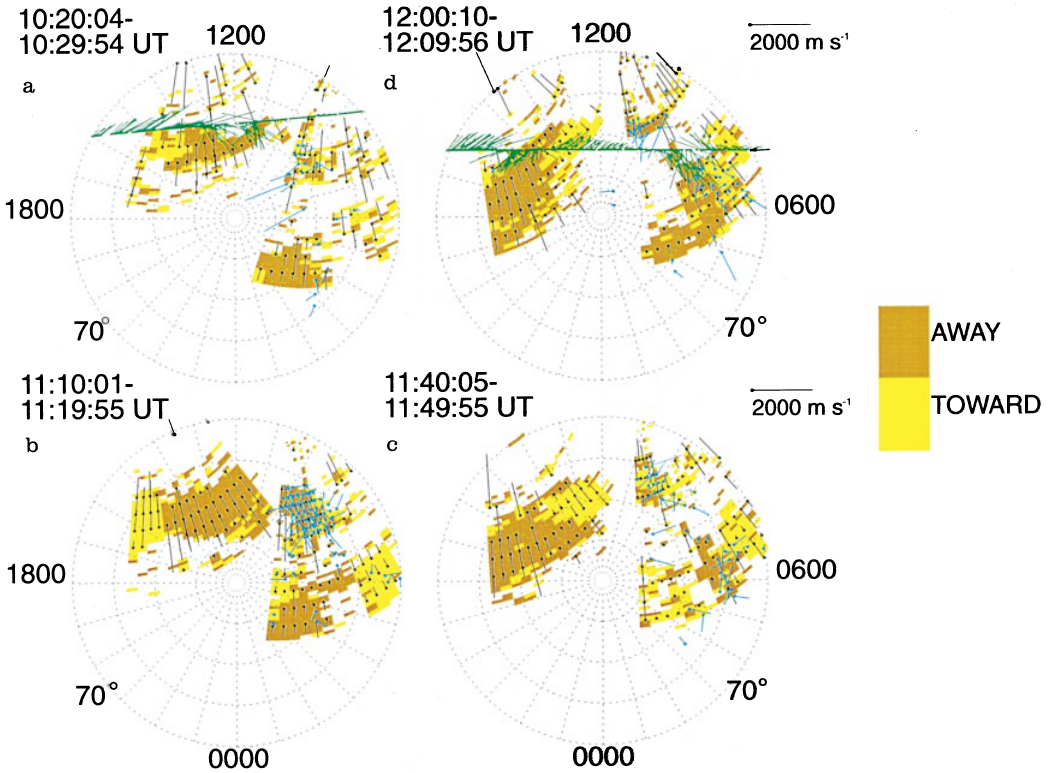
indicated by the key in the figure. L-o-s data from the CUTLASS- Finland and Iceland-West radars are also represented by the colour- coding , with flow toward the radar shown as yellow areas , and flow away as brown . A selection of l-o-s vectors showing the magnitude of the l-o-s velocities are also plotted as black symbols . Flows measured along the dusk-to-dawn track of the DMSP-F11 spacecraft are presented as green vectors in a and d , using the same scale as for the